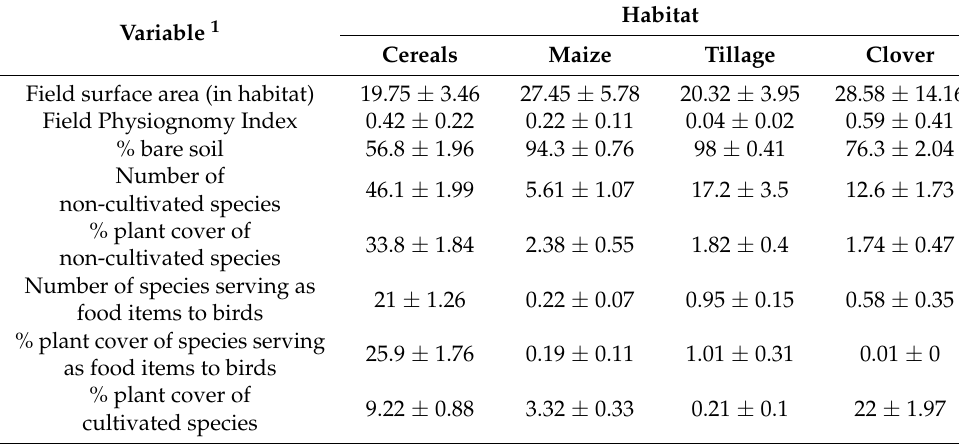
Table A2. Mean ( ± Standard Deviation) above-ground variable estimations in the studied